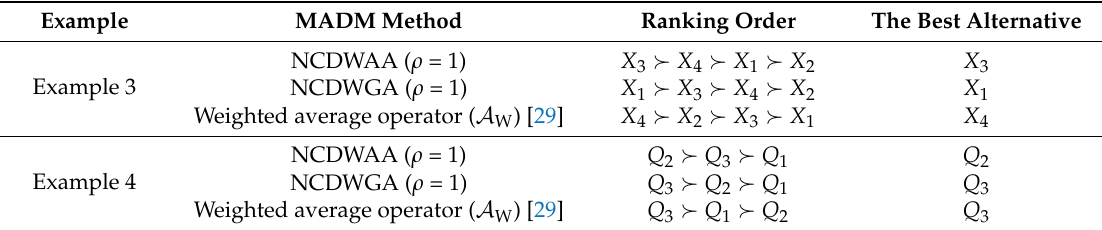
Table 5. Decision results of MADM problem with neutrosophic cubic